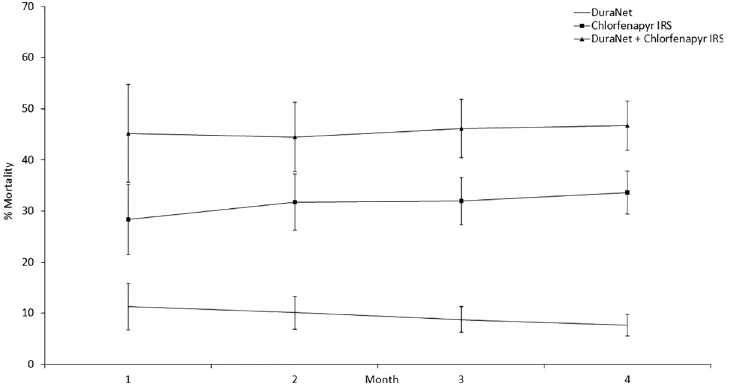
Fig 2. Monthly mortality rates of wild, free-flying pyrethroid-resistant Anopheles gambiae sensu lato entering experimental huts with chlorfenapyr IRS applied alone and in combination with DuraNet 1 in Cov è , southern Benin. Mortality was cumulated over successive months. Error bars represent 95%